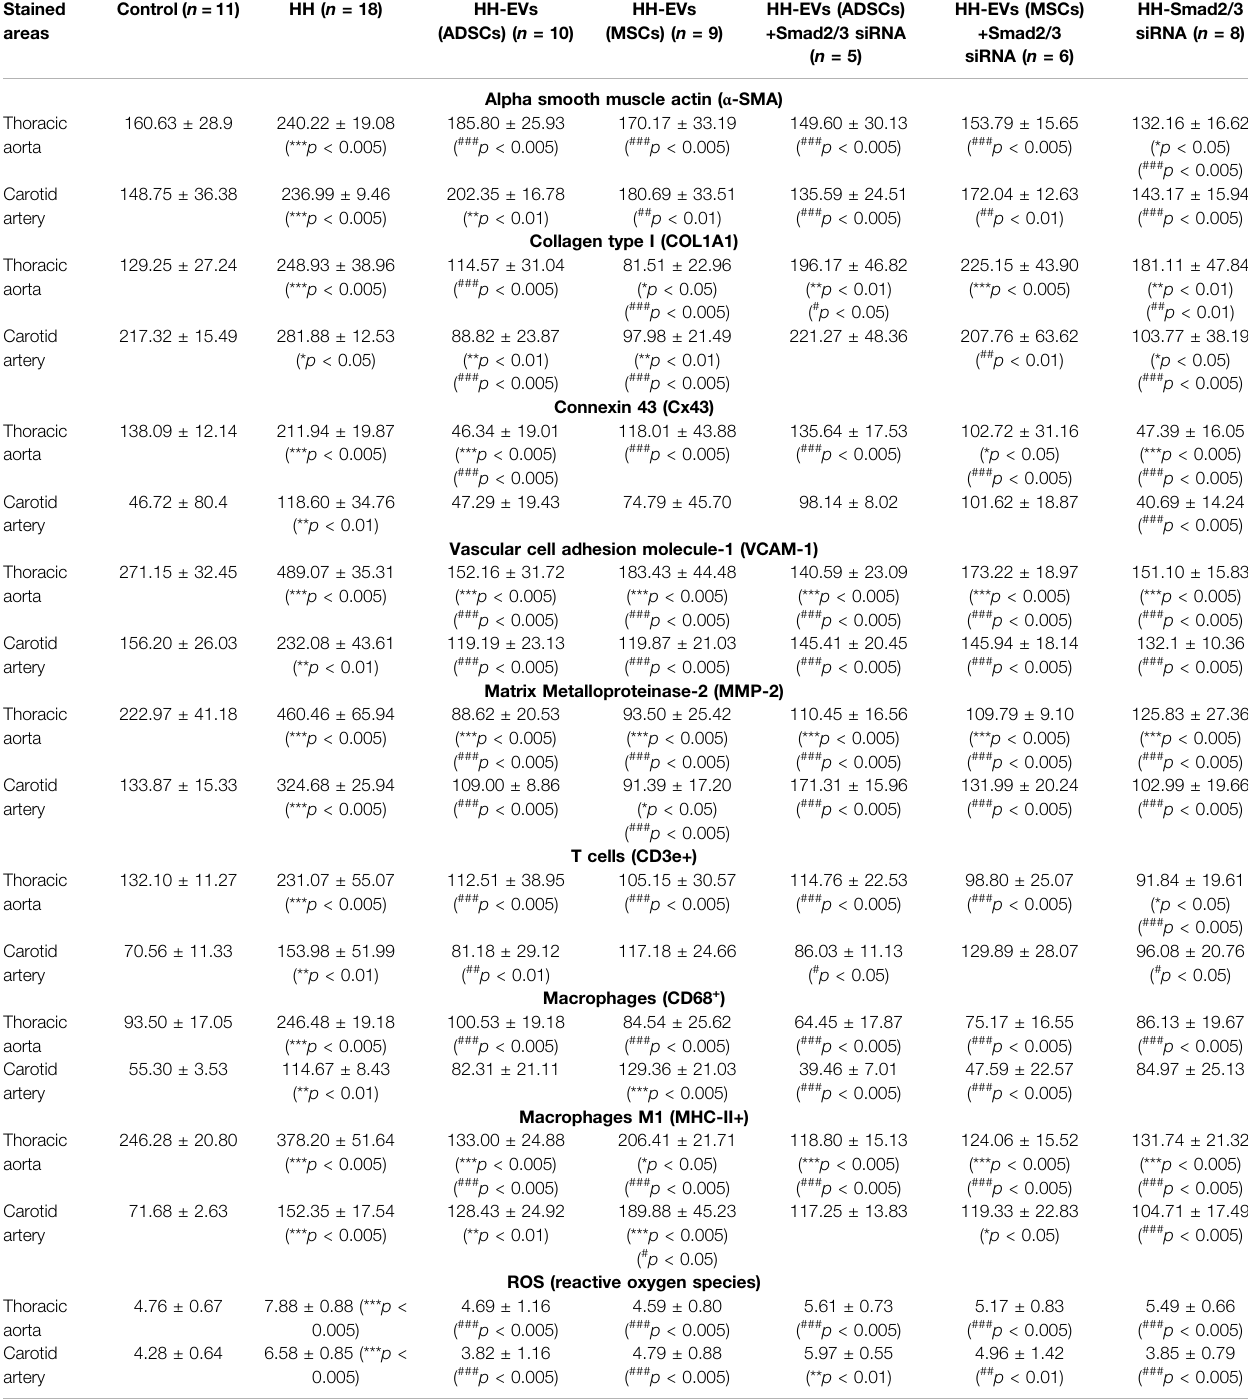
TABLE 2 | Quanti fi cation of the stained areas of in fl ammatory markers from the fl uorescence images of the thoracic aorta and carotid artery sections collected from all investigated animal groups. Results were expressed as mean ± SD. The statistical signi fi cance, noticeably different, was represented as *** p < 0.005, ** p < 0.01, * p